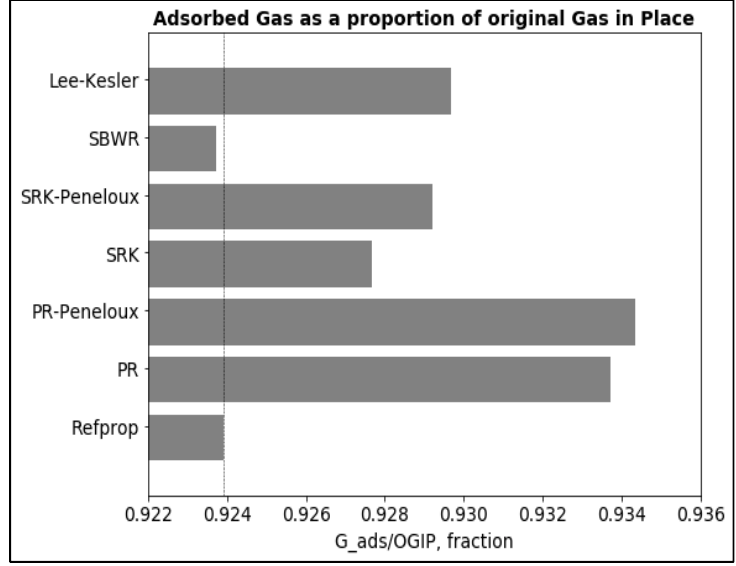
Figure 10. Adsorbed gas as a ratio of the original gas in-place.